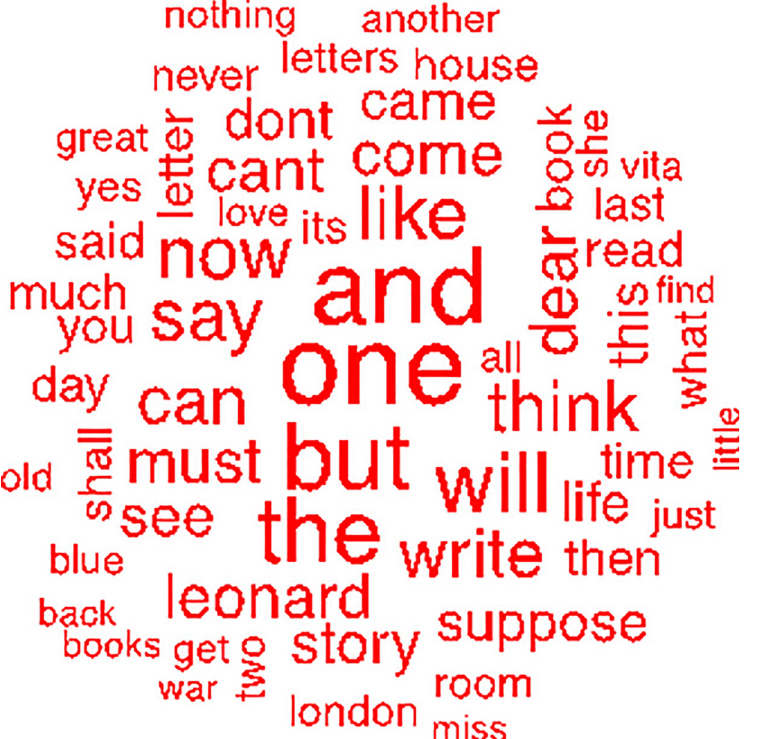
Fig 2. Word cloud of words written in the last 60 days before Virginia Woolf’s